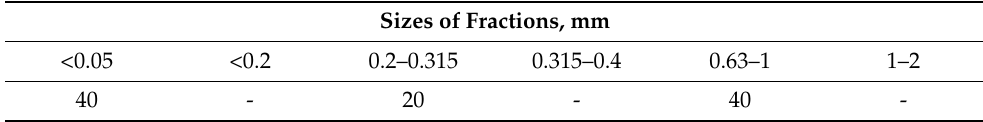
Table 1. Granulometric composition of ceramics (wt.%).